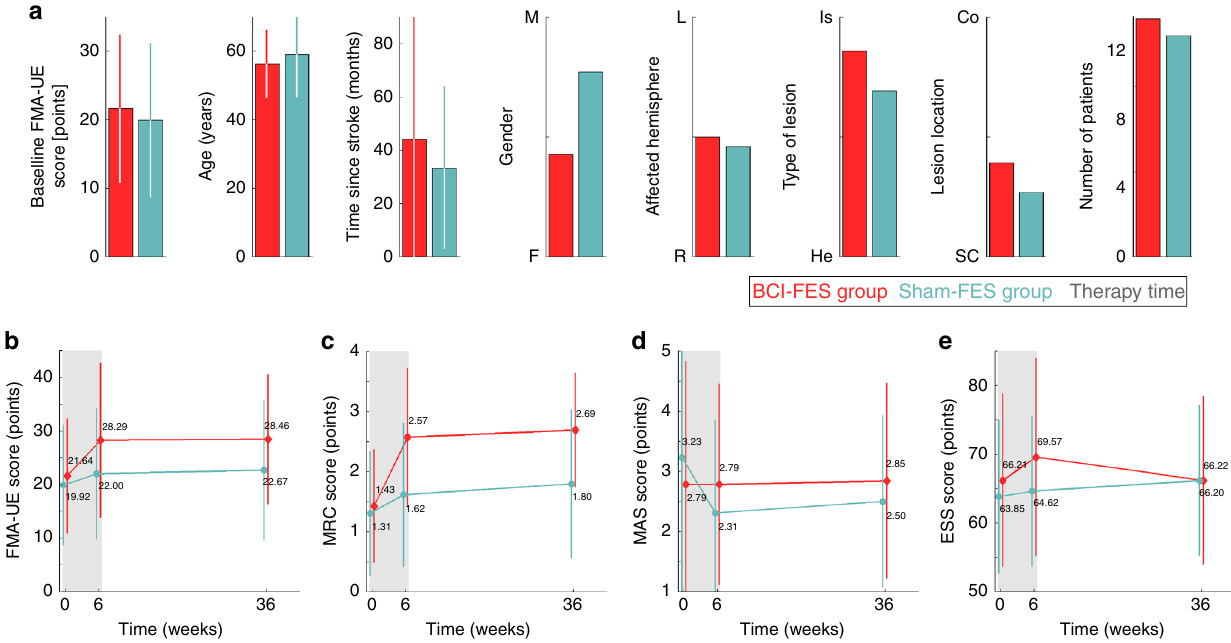
Fig. 1 Patient demographics and clinical scores. All plots report mean values± standard deviation for BCI – FES group ( N = 14, red) and sham-FES group ( N = 13, light blue). a Patients ’ main characteristics, including baseline Fugl-Meyer score (upper extremity), age, time since stroke, gender, affected hemisphere, type of lesion, lesion location, and number of patients per group. No statistical signi fi cant difference between groups was found for any of these factors before the intervention ( p > 0.05 for all tests). b Primary outcome is the Fugl-Meyer assessment for the upper extremity (FMA-UE), measuring motor function. FMA-UE scores are reported immediately before patients received the intervention, immediately after it ended (6 weeks) and at a follow-up session done 6 – 12 months after the end of the intervention (average 36 weeks). The BCI group exhibited a signi fi cant (TIME x GROUP interaction, p = 0.04) and clinically relevant functional recovery after the intervention (6.6 ± 5.6 FMA-UE points, above the threshold of 5 points) that was retained 6 – 12 months after the end of the therapy (Bonferroni-corrected two-tailed paired t -test, p = 0.56). c – e Secondary outcome scores: